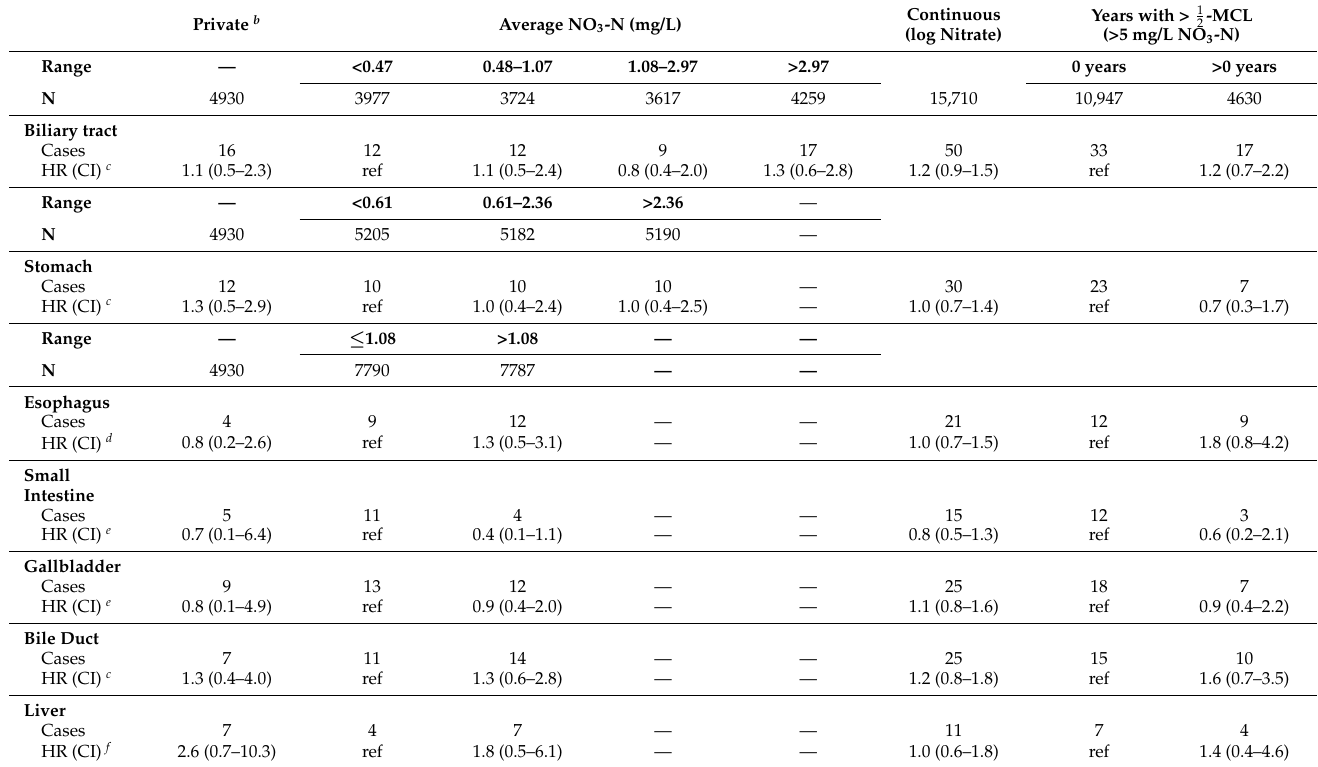
Table 4. Association between specific digestive system cancers and average drinking water nitrate-nitrogen (mg/L), continuous nitrate (log nitrate), years above half the maximum contaminant level (MCL), and private water (N = 20,507). a Quartile groups for biliary tract cancer. Tertile groups for stomach cancer. Median groups for esophagus, small intestine, gallbladder, bile duct, and liver